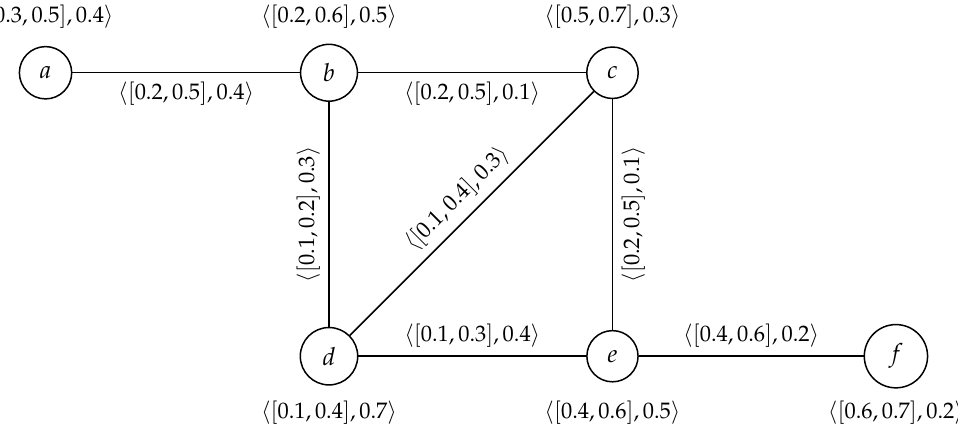
Figure 1. The CG G